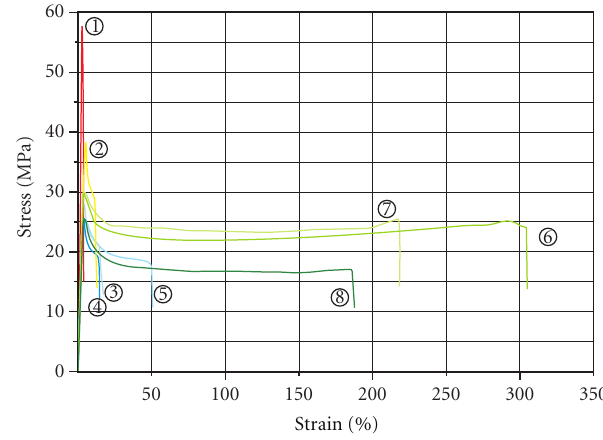
F 2: Stress-strain curves in cross